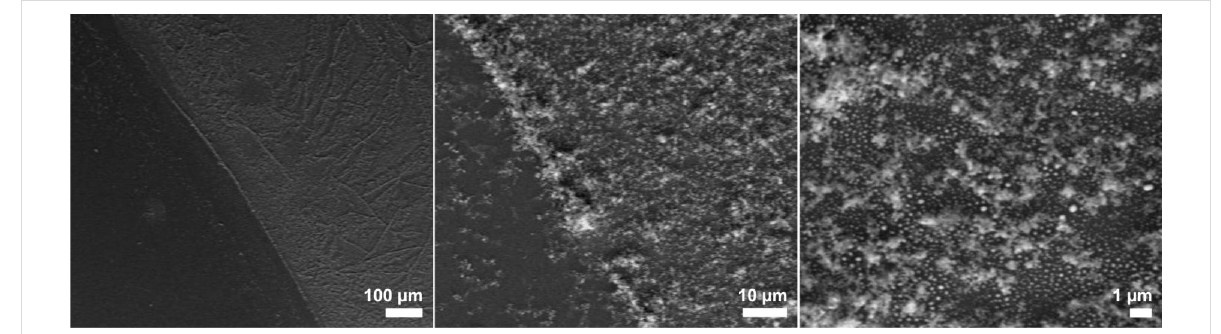
Figure 13: SEM images (different magnifications) of Si NWs obtained from UV-patterned spin-coated “liquid bright gold” films after annealing at 650 °C, followed by treatment with NPS at 375 °C for 1 h.